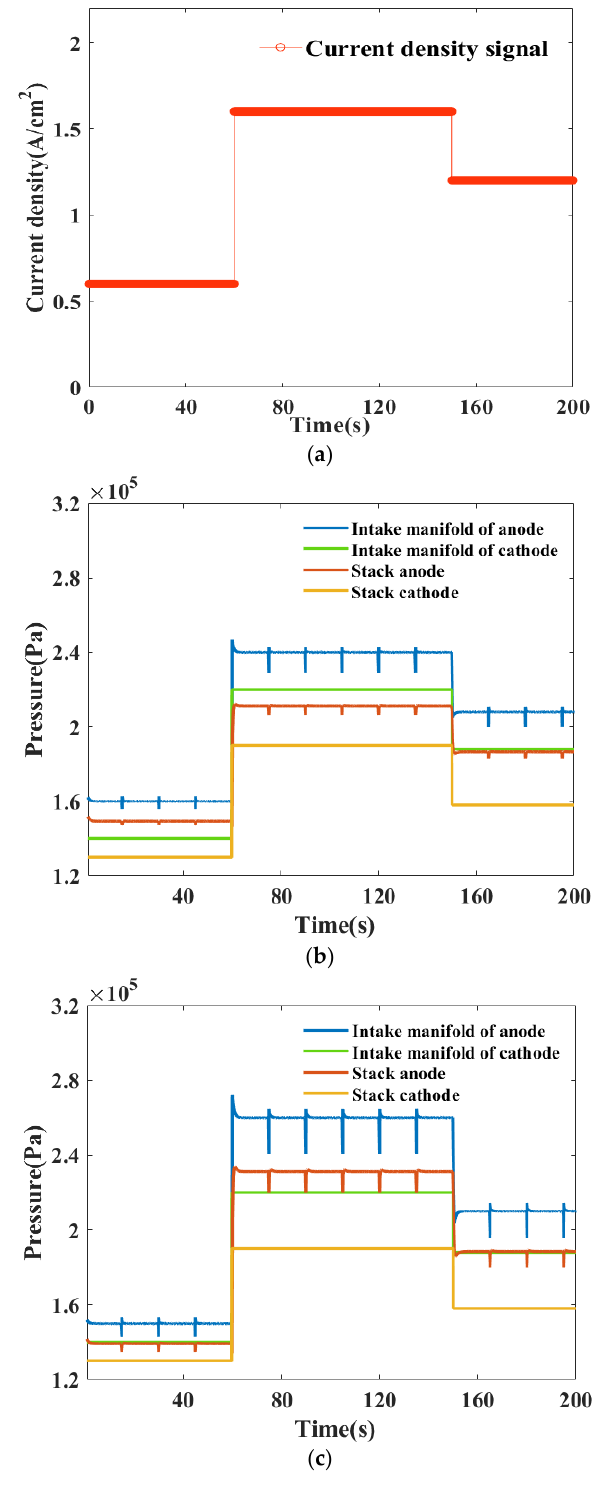
Figure 4. ( a ) Variable loading condition. ( b ) Pressure fluctuation curves of cathode, anode, intake manifold with variable load under PID mode. ( c ) Pressure fluctuation curves of cathode, anode, intake manifold with variable load under non-PID mode.